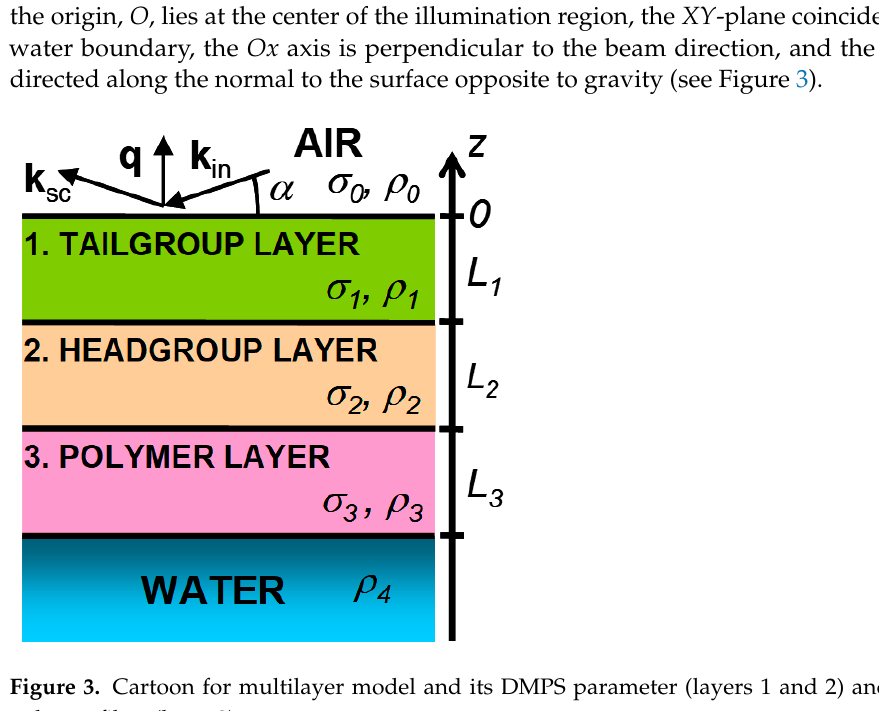
Figure 3. Cartoon for multilayer model and its DMPS parameter (layers 1 and 2) and adsorbed polymer films (layer